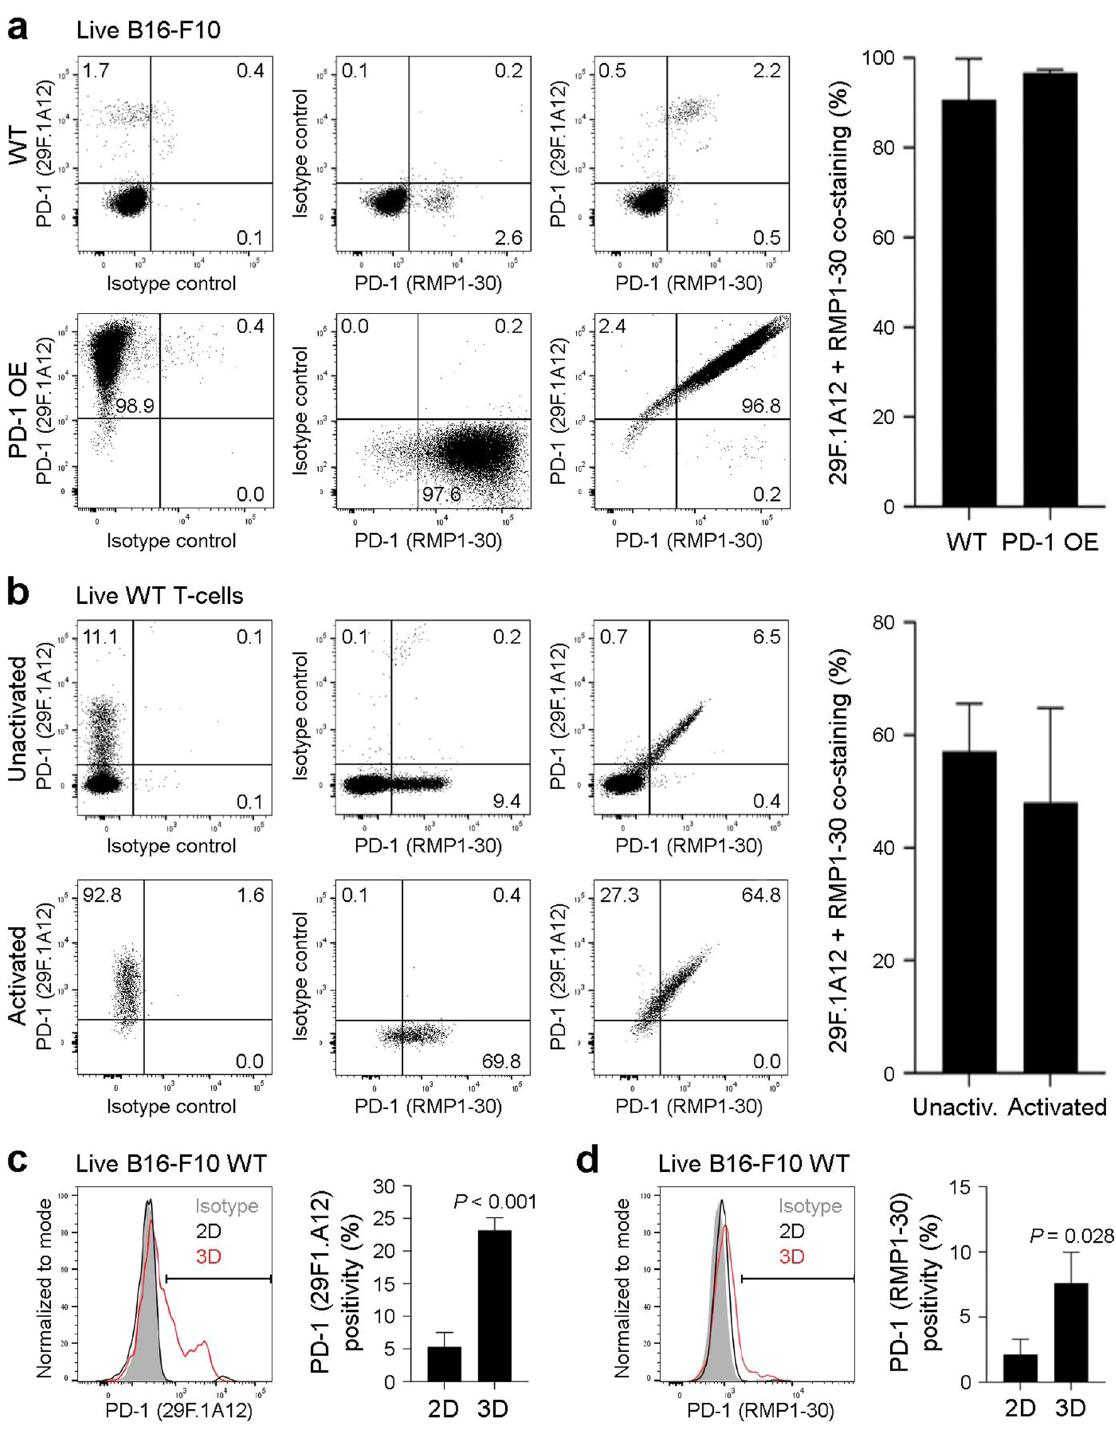
Figure 5. The 29F.1A12 and RMP1-30 anti-PD-1 antibody clones recognize overlapping B16-F10 melanoma subpopulations. ( a,b ) Representative FACS plots of 29F.1A12 and RMP1-30 co-staining (left) and % dual positivity (mean ± s.e,m., calculated as a fraction of RMP1-30-reactive cells) of PD-1 surface protein expression (right) by live (FVD − ) ( a ) B16-F10 wild-type (WT) versus PD-1-overexpressing (OE) melanoma cells or ( b ) unactivated versus activated WT T-cells (C57BL/6) reveals co-localization of PD-1 antibody binding. ( c,d ) Representative histograms (left) and % positivity (mean ± s.e.m.) of PD-1 surface protein expression (right) by live (FVD − ) B16-F10 WT cells grown in standard (2D, black line) versus tumor spheroid (3D, red line) culture conditions, as determined by the ( c ) 29F.1A12 or ( d ) RMP1-30 anti-mouse PD-1 antibody clones. Results are representative of at least n = 3 independent experiments. * p < 0.01; *** p <